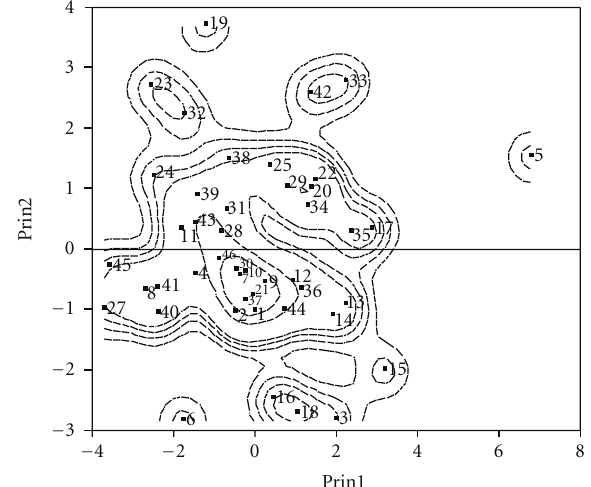
Figure 1: Scatter diagram of the lentil landraces based on studied traits. Cu had the highest positive coe ffi cients. PC3 accounted for 13% of the total variation, and seed potassium was the main trait. PC4 explained 9% of the variation, and seed protein was the main trait (Table 4). The scattering and relationship of lentil landraces according to principal component analysis are shown in Figure